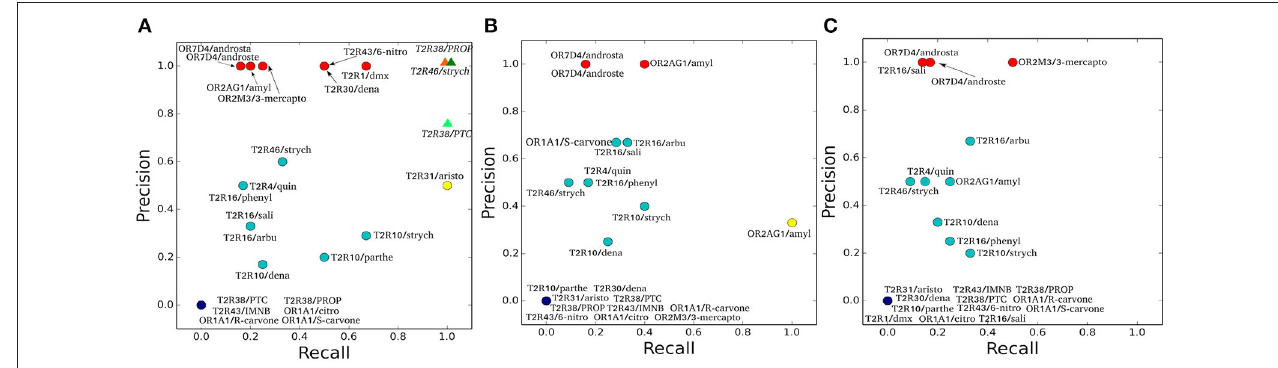
FIGURE 1 | Precision and Recall plots for the predictions of hChem-GPCR/agonist complexes. (A-C) show the HADDOCK (Dominguez et al., 2003), AutoDock Vina (Trott and Olson, 2010), and Glide (Friesner et al., 2004) docking predictions, respectively. The abbreviations used for the hChem-GPCR/agonist complexes are listed in Table 2 . Bioinformatics/Docking-based predictions are shown as circles, colored according to the two performance metrics: dark blue (0 precision, 0 recall), red (precision 1, low recall), yellow (low precision, recall 1) and cyan (all the rest, with intermediate precision and recall values). In panel A, MM/CG simulation results (Marchiori et al., 2013; Sandal et al., 2015), started from Haddock docking complexes, are displayed as colored